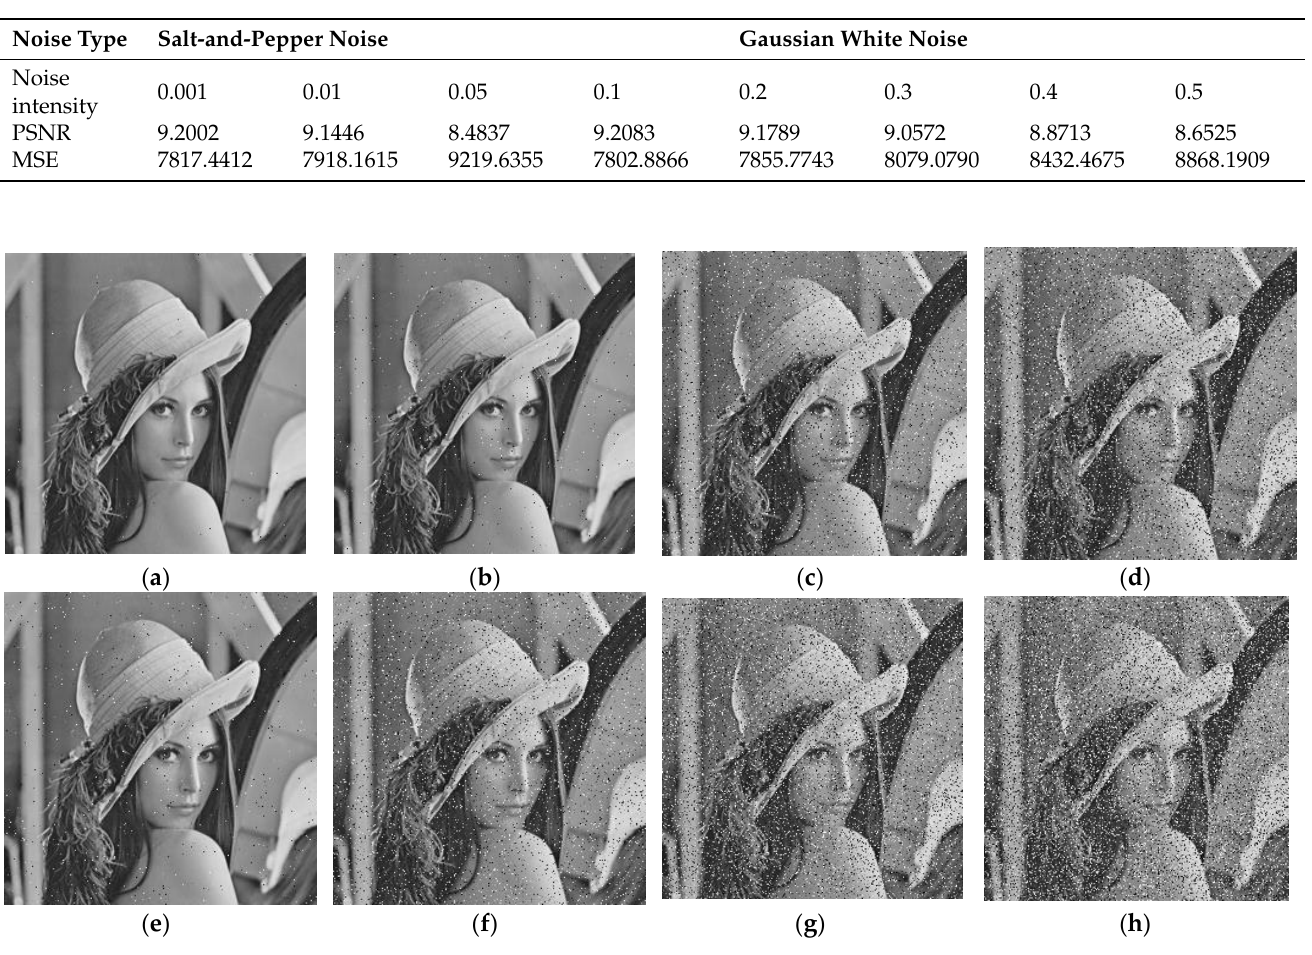
Figure 11. Noise attack test. ( a – d ) with salt-and-pepper noise densities of 0.001, 0.01, 0.05, 0.1, respectively; ( e – h ) with Gaussian white noise variance values of 0.2, 0.3, 0.4,0.5 respectively.